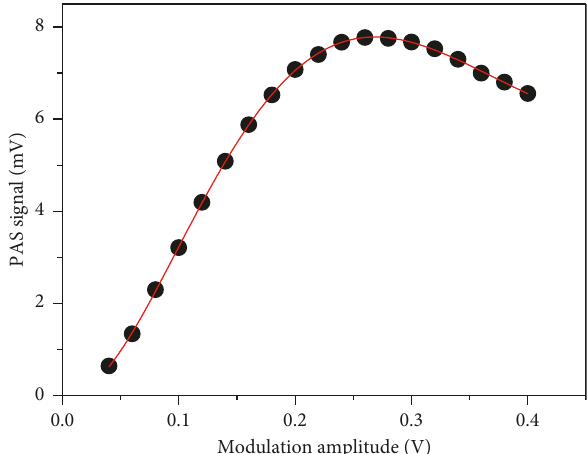
2 H 6 concentration.